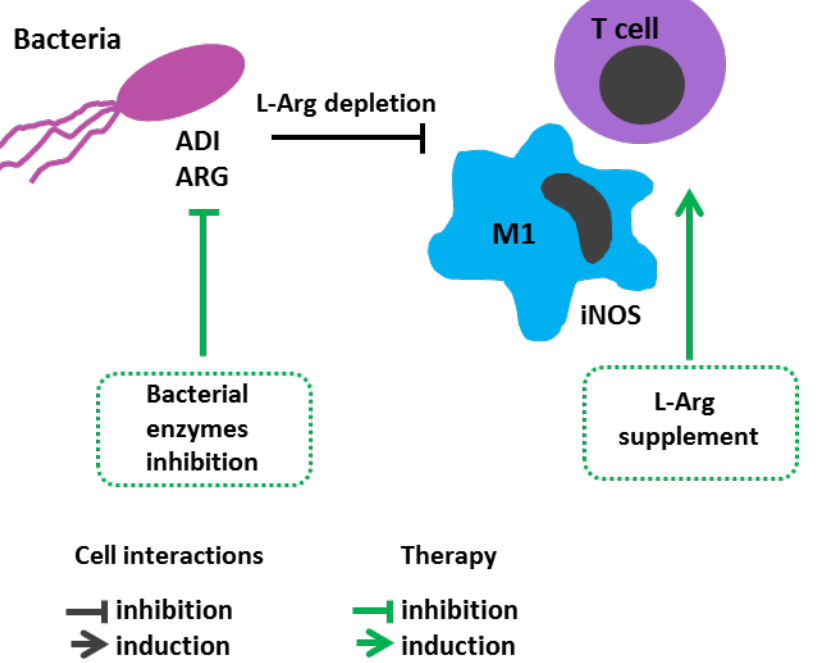
Figure 4. L-Arginine metabolism in bacterial infection immunopathogenesis and arginine-dependent processes as a target of therapeutic approaches. Pathogenic microbes affect L-Arg metabolism to reprogram host immune responses. Reduced L-Arg level suppresses T cell response, results in substrate depletion for iNOS, thereby reducing NO production.Therapeutic strategies: Oral administration of L-Arg reduces bacterial load and enhances T cell responses, as well as iNOS activity.ADI-PEG20, pegylated arginine deiminase; ARG, bacterial arginase; iNOS, inducible nitric oxide synthase; L-Arg, L-arginine; M1, M1